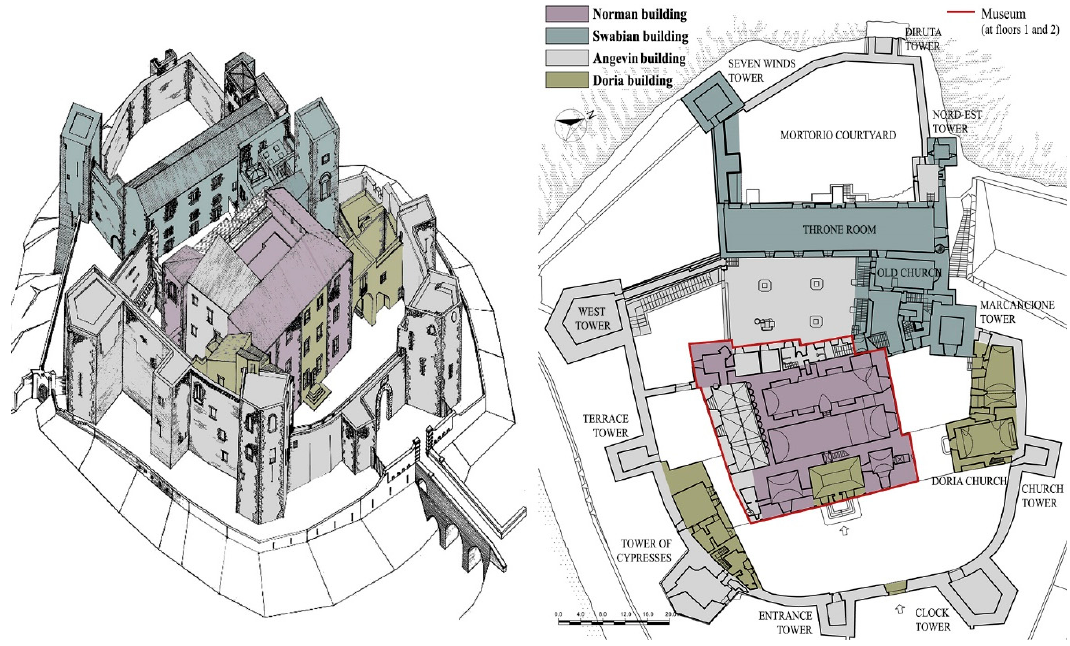
Figure 3. Constructive phases of the Castle of Melfi—axonometric view adapted from [9].